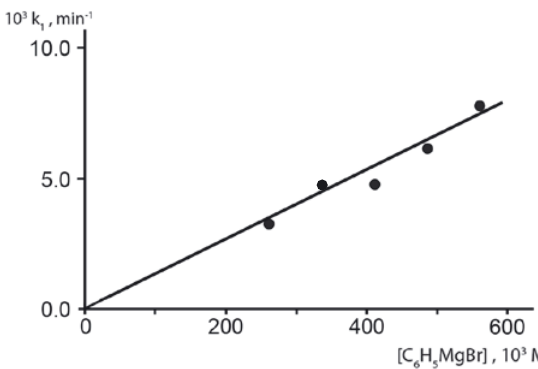
Figure 3. Effect of phenyl magnesium bromide ( 1a ) concentration on the pseudo-first order rate constants for the reaction of phenyl magnesium bromide ( 1a ) with phenyl tosylate ( 2 ) in THF: toluene (7:10) at 90 o C. Data are from Table 1.